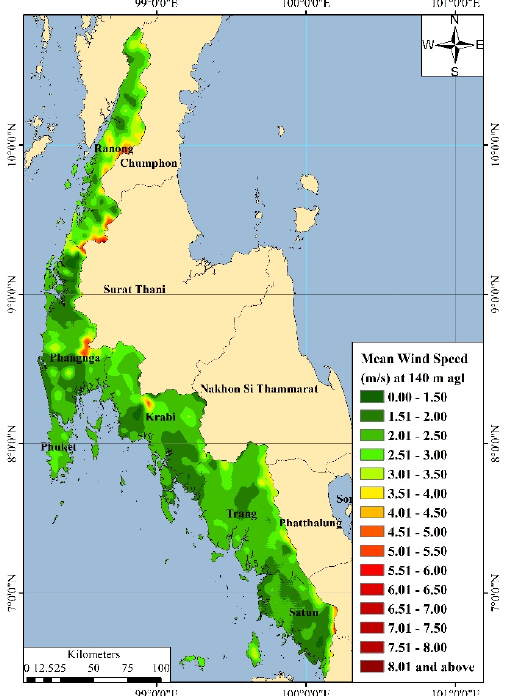
Figure 6. Microscale wind resource map at 120 m agl for the western coast of Southern Thailand.